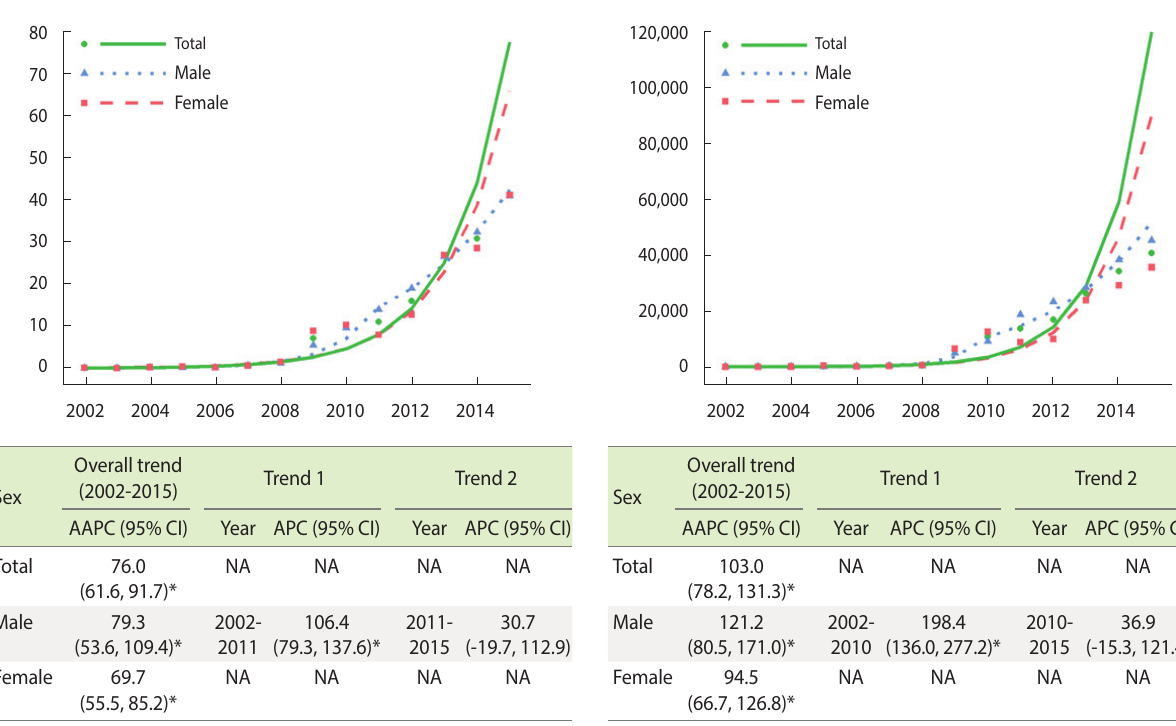
Figure 1. The age-standardized APC and AAPC of opioid prescrip- tions as cases per 10.000 registrants during 2002-2015 by sex. AAPC, average annual percentage change; APC, annual percentage change; CI, confidence interval; NA, not applicable. *p<0.05.